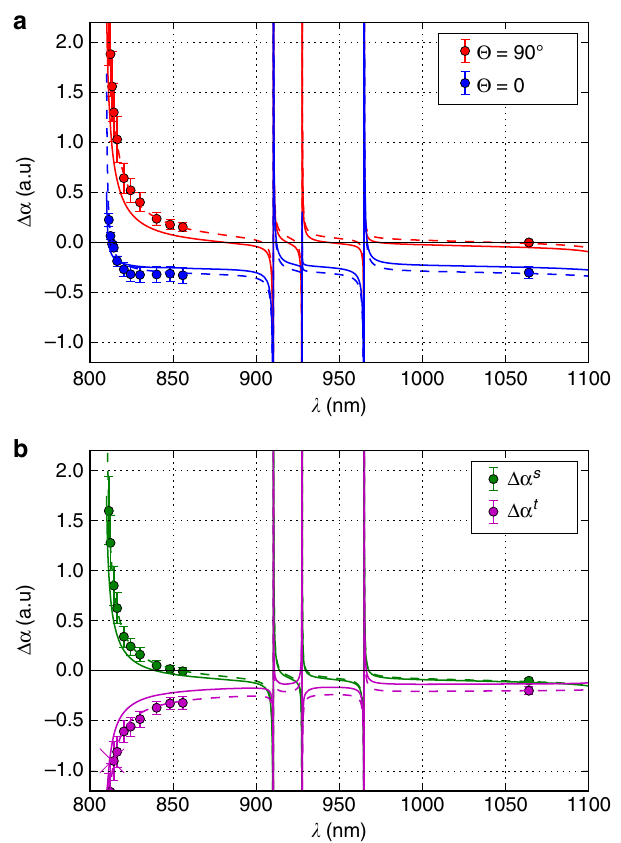
Fig. 4 Differential polarizability spectra. a Differential dynamic polarizability Δ α ( λ ) for Θ = π /2 (red dots) and Θ = 0 (blue dots). b Corresponding scalar Δ α s ( λ ) (green dots) and tensor Δ α t ( λ ) (magenta dots) parts. The magenta cross is Δ α t ( λ m ) determined from measurements in Fig. 3b. The solid and dotted curves are calculations based on Models 1 and 2, respectively (see Methods section). Error bars represent 1 s.d. of the measured polarizability values To fi nd Δ α t , we measured the dependency of the clock transition frequency shift Δ ν for a small magnetic fi eld B y using the constant-bias fi elds B x = 225 mG and B z = 0 ( Θ ≈ B y / B x ) as shown in Fig. 3b. From the corresponding parabolic coef fi cient of − 56(11) mHz mG − 2 , we obtained a differential tensor polariz- ability of Δ α t = − 0.9(2) a.u. at λ m . The uncertainty comes from the absolute calibration of the magnetic fi eld and power calibration (see the Methods section). Both lattice frequency